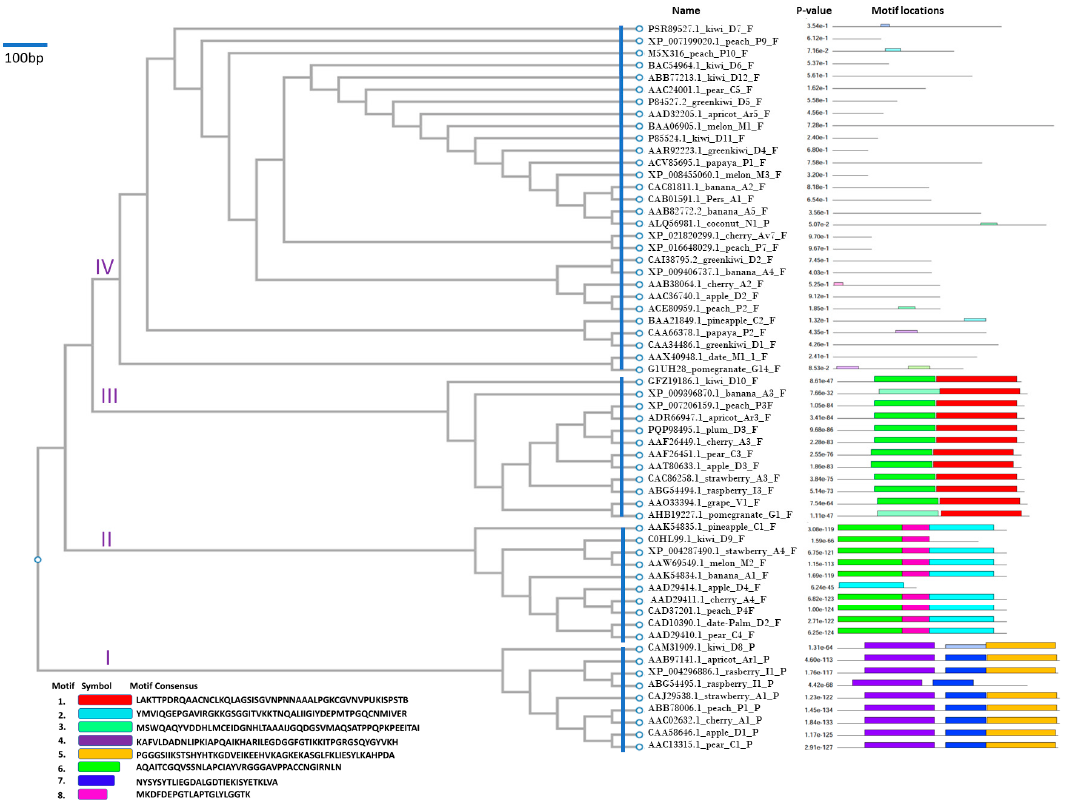
Figure 1. Phylogenetic and motif analyses. All of the 60 allergens were classified into four clusters, which were marked as I, II, III, IV. The logos of hidden Markov models and p -value of conserved motif for each allergen are